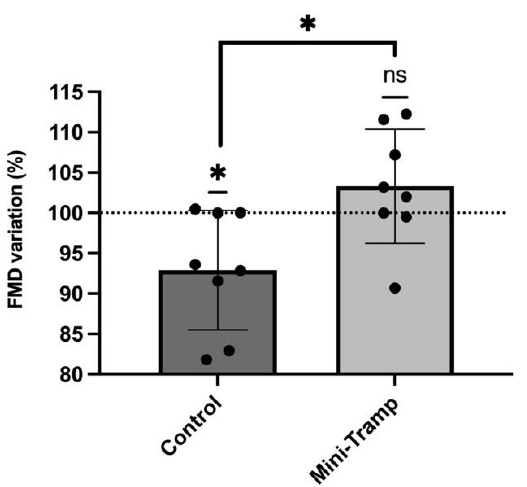
Figure 2. Effects of mini trampoline preconditioning compared to control on endothelial function as measured by FMD. Pre-dive values are taken as reference (100%). Data are expressed as means ± SD. (* = p < 0.05; ns = Not Significant).